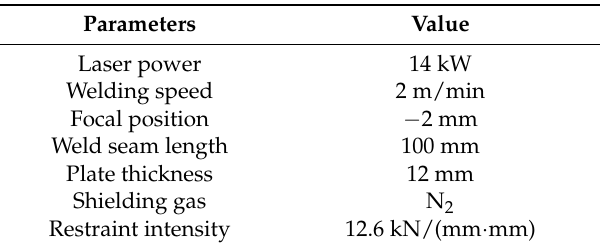
Table 2. Welding parameters used in the experiments.